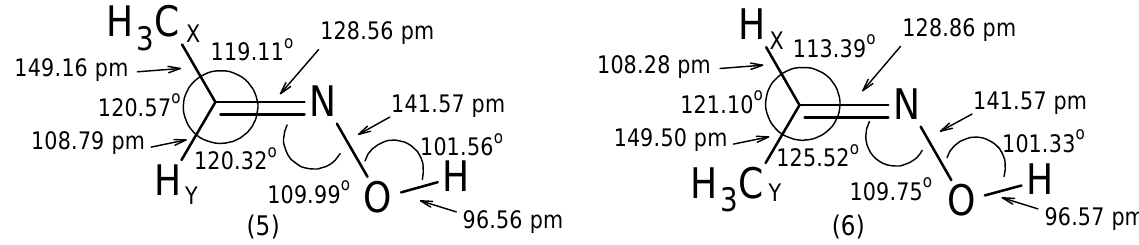
Figure 3. Optimized MP2/6-31G** geometries of the (E)-ethanaloxime ( 5 ) and (Z)-ethanaloxime ( 6 ). One of the C-H bonds in the H C- group is eclipsed to the C=N bond in (E)-ethanaloxime, whereas it 3 is eclipsed to the C-H bond in the (Z)